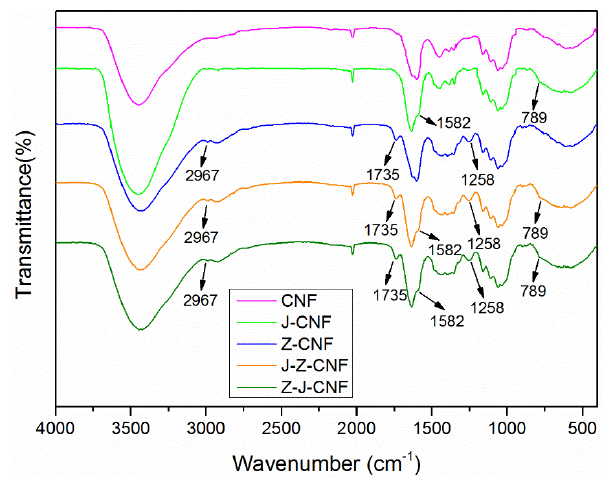
Figure 3. Fourier-transform infrared spectrometry (FT-IR) spectra of CNF and modified CNF samples.